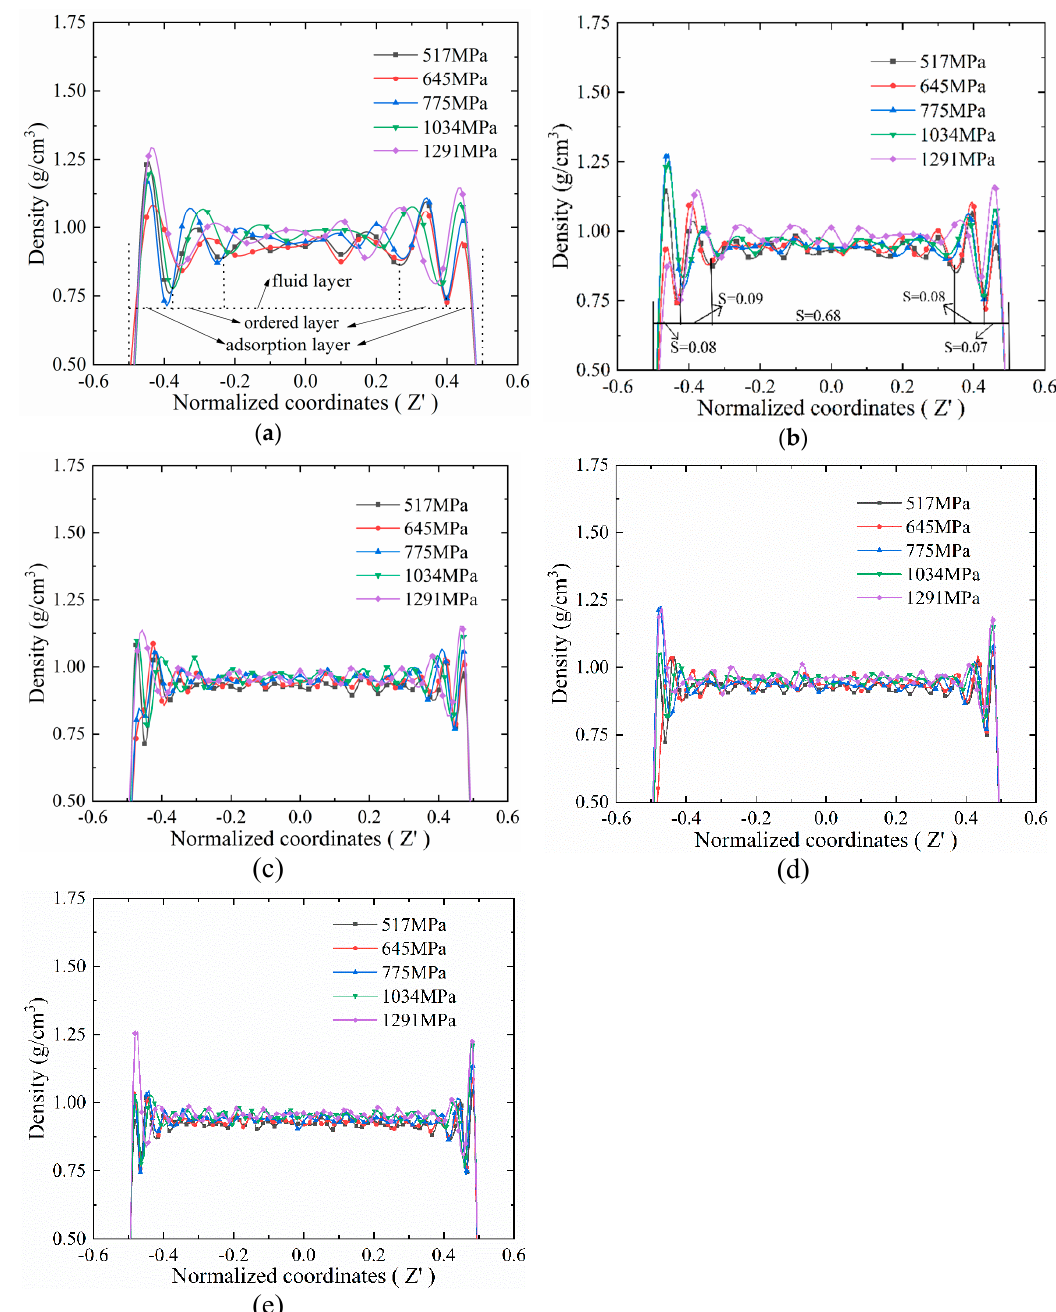
Figure 7. The density distribution curve of lubrication film with different initial film thickness: ( a ) h 0 = 6 nm; ( b ) h 0 = 8 nm; ( c ) h 0 = 11 nm; ( d ) h 0 = 14 nm; ( e ) h 0 = 17 nm.